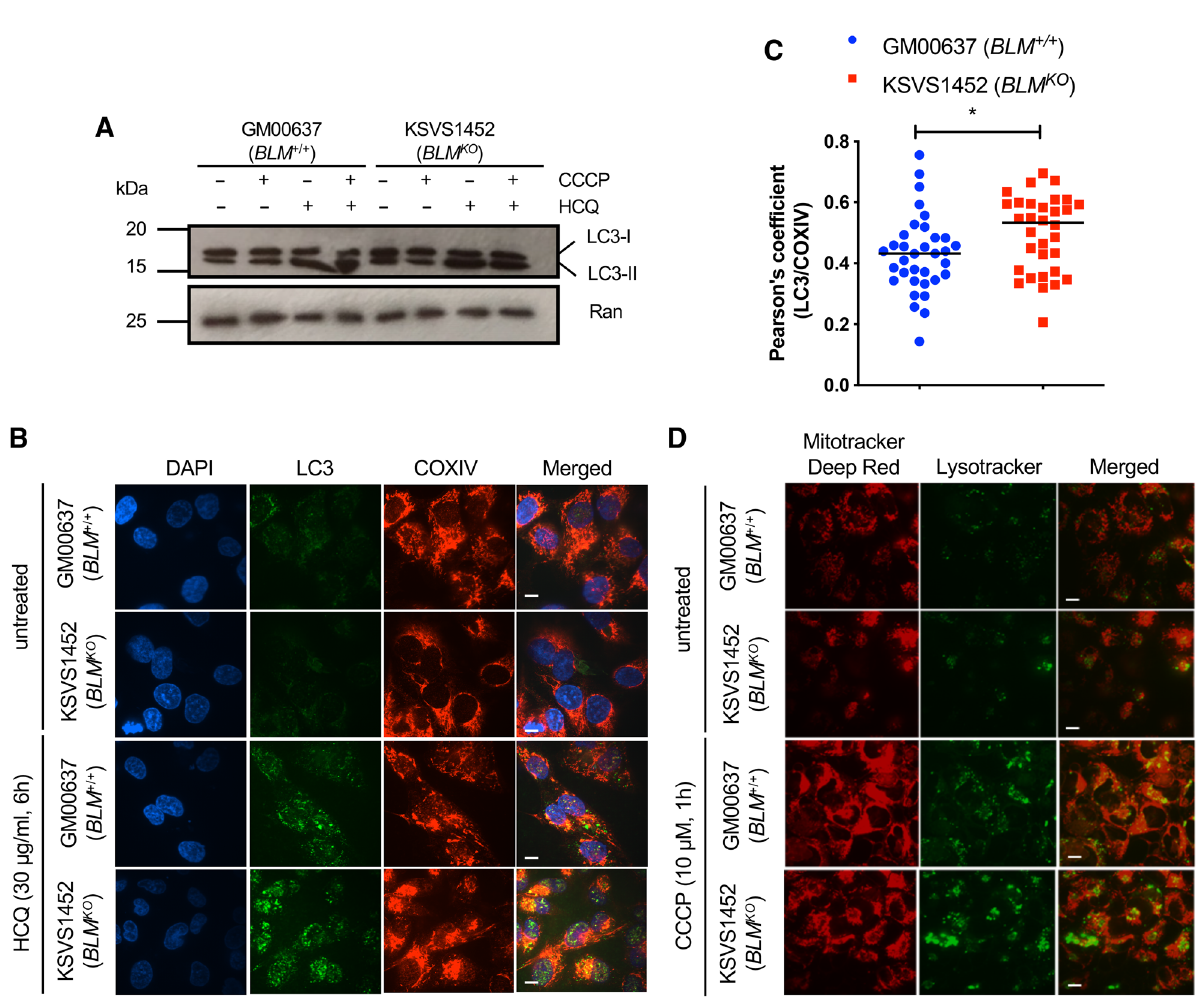
Figure 3. BLM-deficient cells are proficient in autophagy. ( A ) Western blot analysis of GM00637 ( BLM +/+ ) and KSVS1452 ( BLM KO ) cells for levels of cytosolic LC3-I and autophagosomal marker LC3-II. Both, cytosolic LC3-I and membrane-bound LC3-II, were detected with LC3 antibody G-9 (SCBT). Cells were treated with 10 µM CCCP for 6 h to induce autophagy and/or with 30 µg/ml HQC for 6 h to interrupt autophagic flux. ( B ) Confocal microscopy images of fixed GM00637 ( BLM +/+ ) and KSVS1452 ( BLM KO ) cells immunostained for LC3 (MAP LC3β-G-9 (SCBT) and COXIV (Cell Signaling), and stained with DAPI. Cells were treated with 30 µg/ml HCQ for 6 h to interrupt autophagic flux. Scale bars 10 µm. ( C ) Quantification of colocalization of antibody staining for LC3 and COXIV in HCQ-treated cells imaged as in panel B. 30 cells from BLM-proficient GM00637 cells and BLM-deficient KSVS1452 cells were analyzed. Significance of differences was determined by a Student’s t test and is reported as * p ≤ 0.05. ( D ) Confocal microscopy images of BLM-proficient GM00637 cells and isogenic BLM-knockout cells KSVS1452 stained with MitoTracker Deep Red and Lysotracker in the presence and absence of CCCP. Scale bars 10